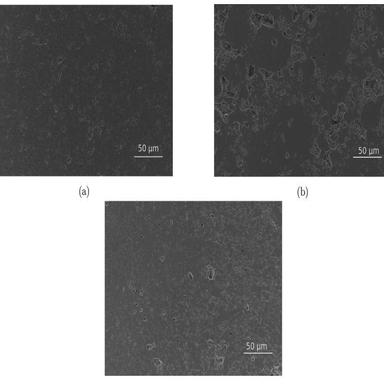
SEM images of samples made of: (a) material 1 (commercial samples), (b) material 2 (in-house prepared samples sintered at 1400◦C) and (c) material 3 (in-house prepared samples sintered at 1500◦C).